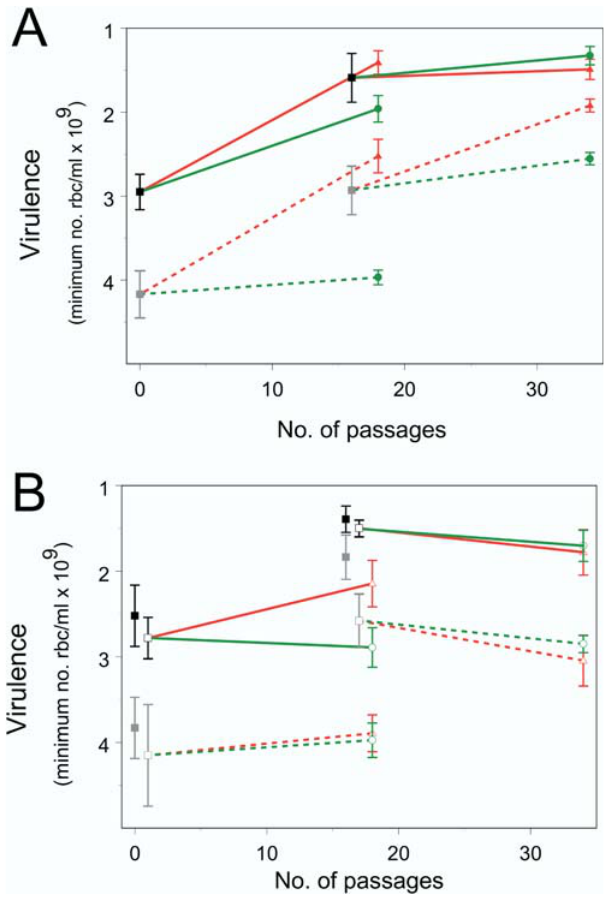
Figure 1. Virulence Evolution in Mouse Malaria during Serial Passage in Immunized Versus Naı¨ve Mice Virulence was measured by minimum red blood cell density (y-axis) in lines of P. chabaudi before ( ‘‘ ancestral lines; ’’ black and gray symbols) and after serial passage through immunized ( ‘‘ I-lines; ’’ red lines and triangles) or naı¨ve ( ‘‘ N-lines, ’’ green lines and circles) mice before (A) and after (B) mosquito transmission. Evolved and ancestral lines were compared in both naı¨ve (solid lines) and immunized mice (broken lines). Filled symbols, before mosquito transmission; open symbols, after mosquito transmission. Lines were selected from an avirulent, ‘‘ unadapted ’’ clone (CW-0; left set of lines) and a virulent, ‘‘ preadapted ’’ ancestral population (CW-A; right): the latter was derived from the former by 12 serial passages in a previous experiment (Mackinnon and Read 1999b). Each symbol (with 6 1 standard error based on the variance between subline means) represents the mean of mice infected with an ancestral line or a set of passaged lines (i.e., five sublines, two mice per subline). Prior to mosquito transmission (A), differences between the I-lines and N- lines were significant in three out of the four cases ( p , 0.05 for lines from the unadapted line infecting naı¨ve mice, p , 0.01 for